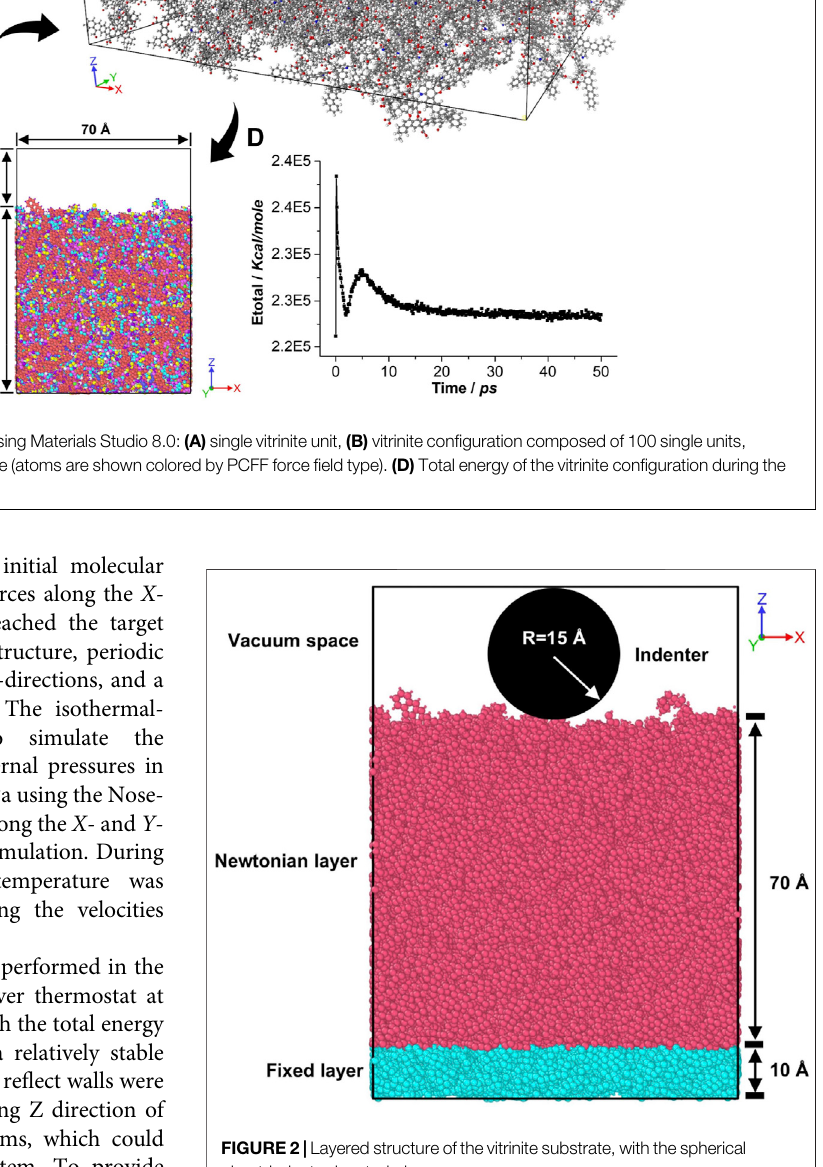
Frontiers in Earth Science |